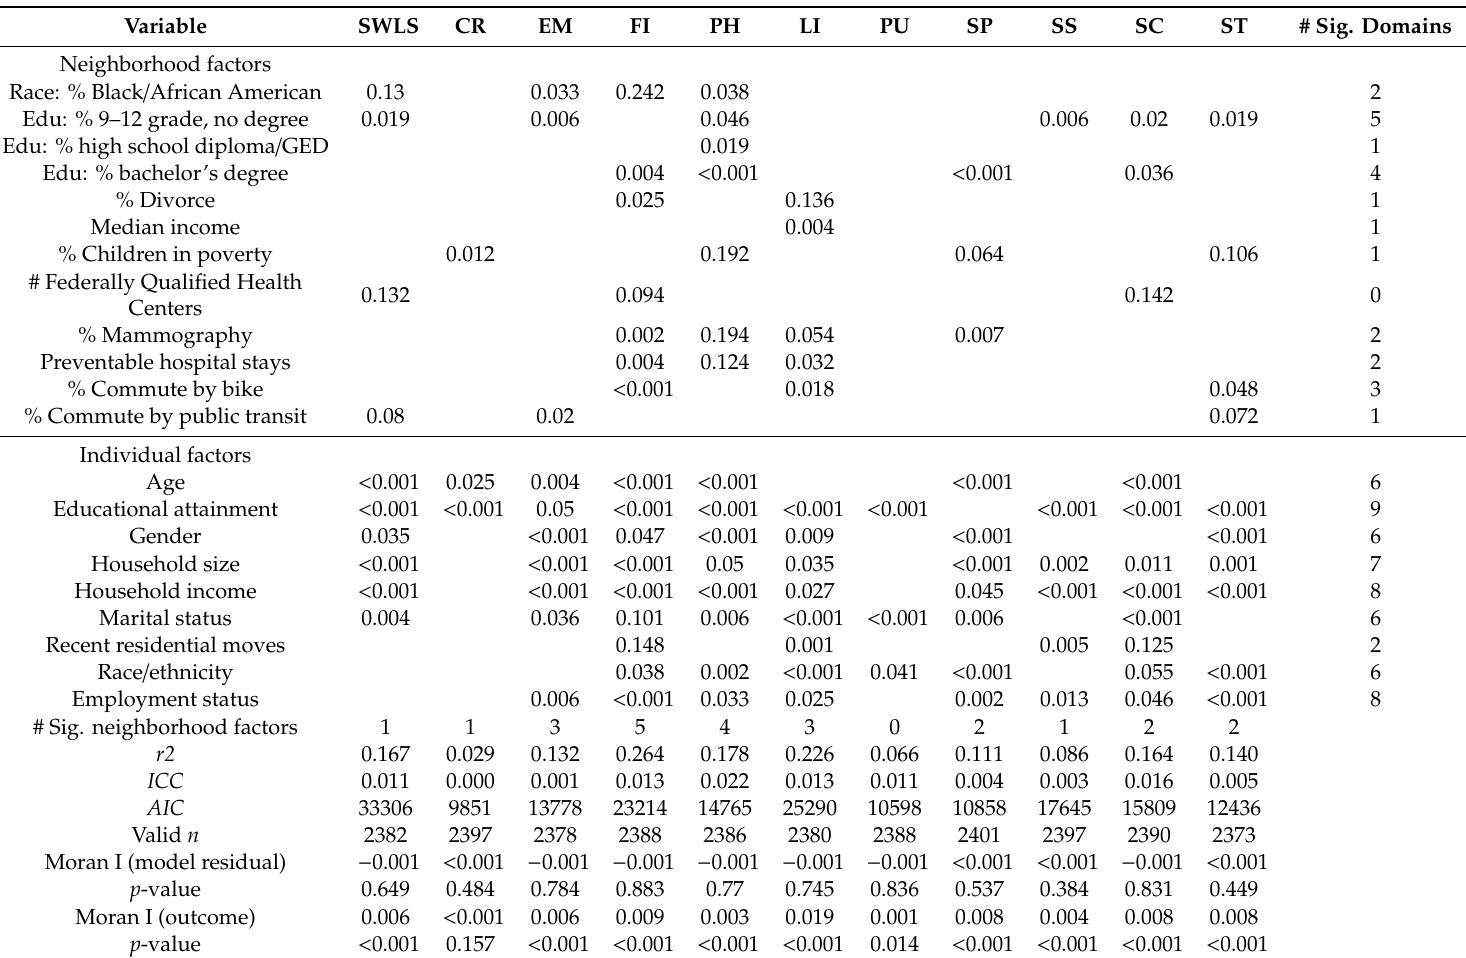
Table 6. Significant di ff erences in well-being outcomes between neighborhood factor quantile groups, adjusted for individual-level covariate (determined by Type II sums of squares tests for ANOVA e ff ects, reported as p